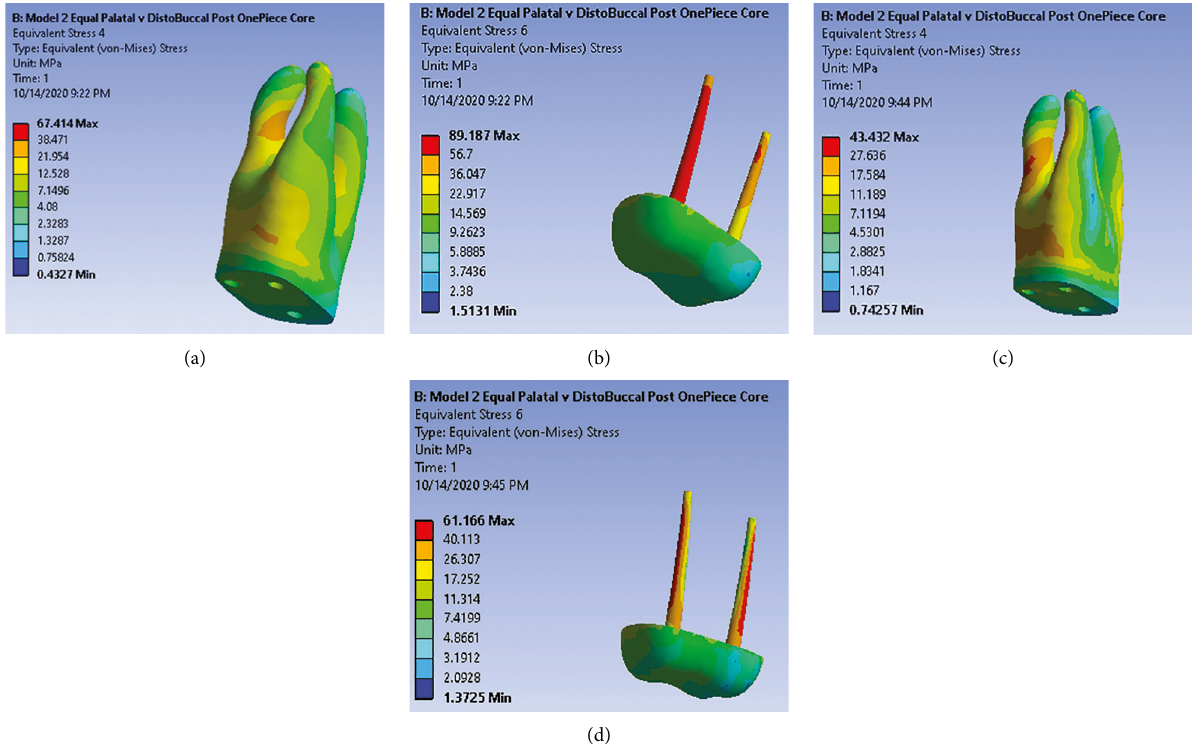
Figure 3: (a) Stress distribution pattern in dentin under 480 (N) along model 2. (b) Stress distribution pattern in post-core under 480 (N) along model 2. (c) Stress distribution pattern in dentin under 240 (N) along model 2. (d) Stress distribution pattern in post-core under 240 (N) along model